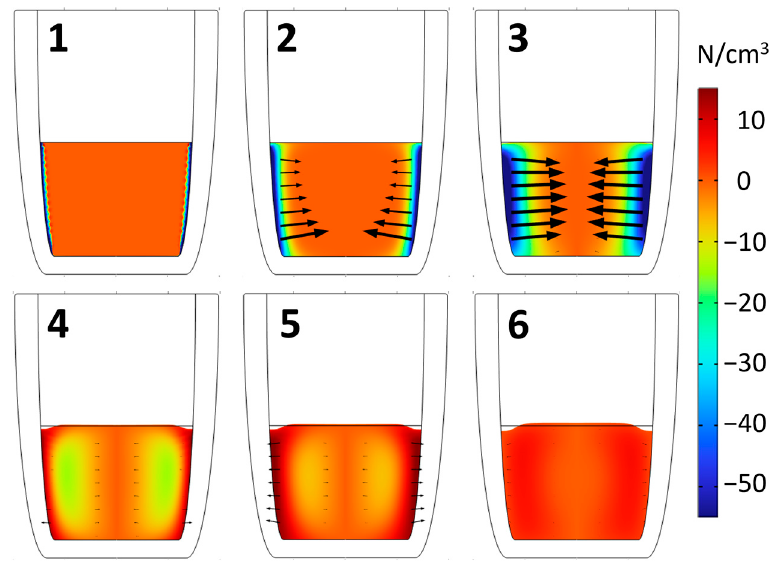
Figure 5. Lorentz force distribution during the first period of the EM pulse: 1—initial, 2—ramp-up, 3—top peak, 4—ramp-down, 5—zero cross, and 6—bottom peak.